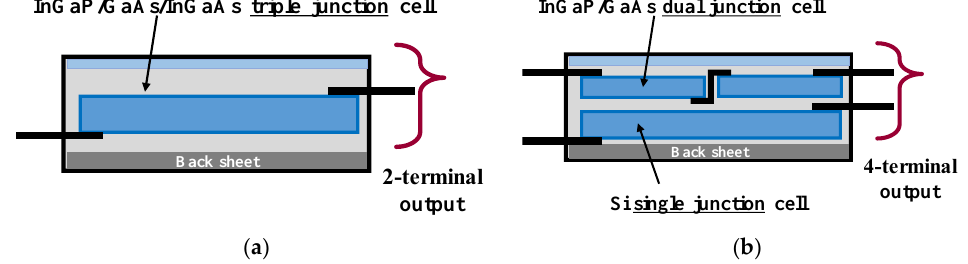
Figure 1. Measured 4-terminal (4T) III-V/Si module and its solar cell structure: ( a ) Description of 2-terminal (2T) III-V 3-junction module; ( b ) Description of measured 4T III-V/Si module, 2 + 1 junctions. Note that the number of junctions is the